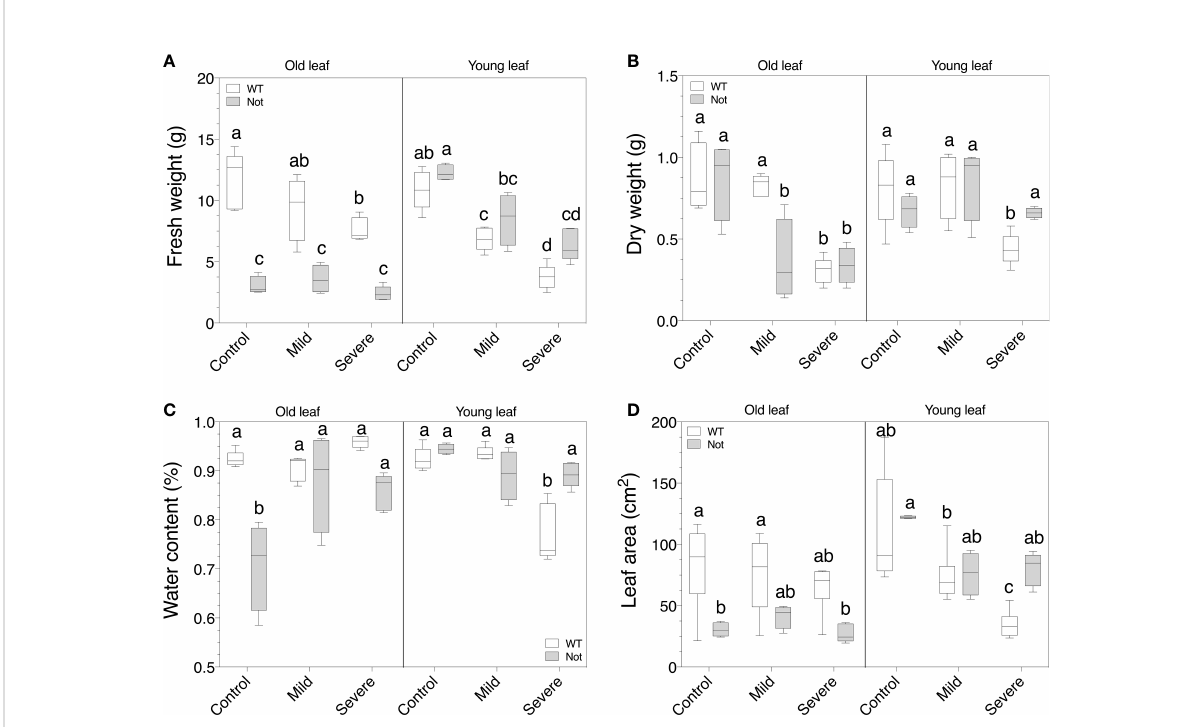
FIGURE 3 Assessment of leaf growth parameters for wild-type and notabilis plants under salt stress. (A) Leaf fresh weight (n = 10), (B) leaf dry weight (n = 10), (C) leaf water content (n = 10) and (D) leaf area (n = 10) of old (leaf no. 3) and young (leaf no. 8) leaves after 7 days under control (EC of 2.5 dS/m), mild (EC of 5 dS/m; [NaCl] = 47 mM) and severe (EC of 10 dS/m; [NaCl] = 94 mM) salt stress conditions for the wild-type (white) and notabilis (gray). Signi fi cant differences are indicated with different letters ( a =